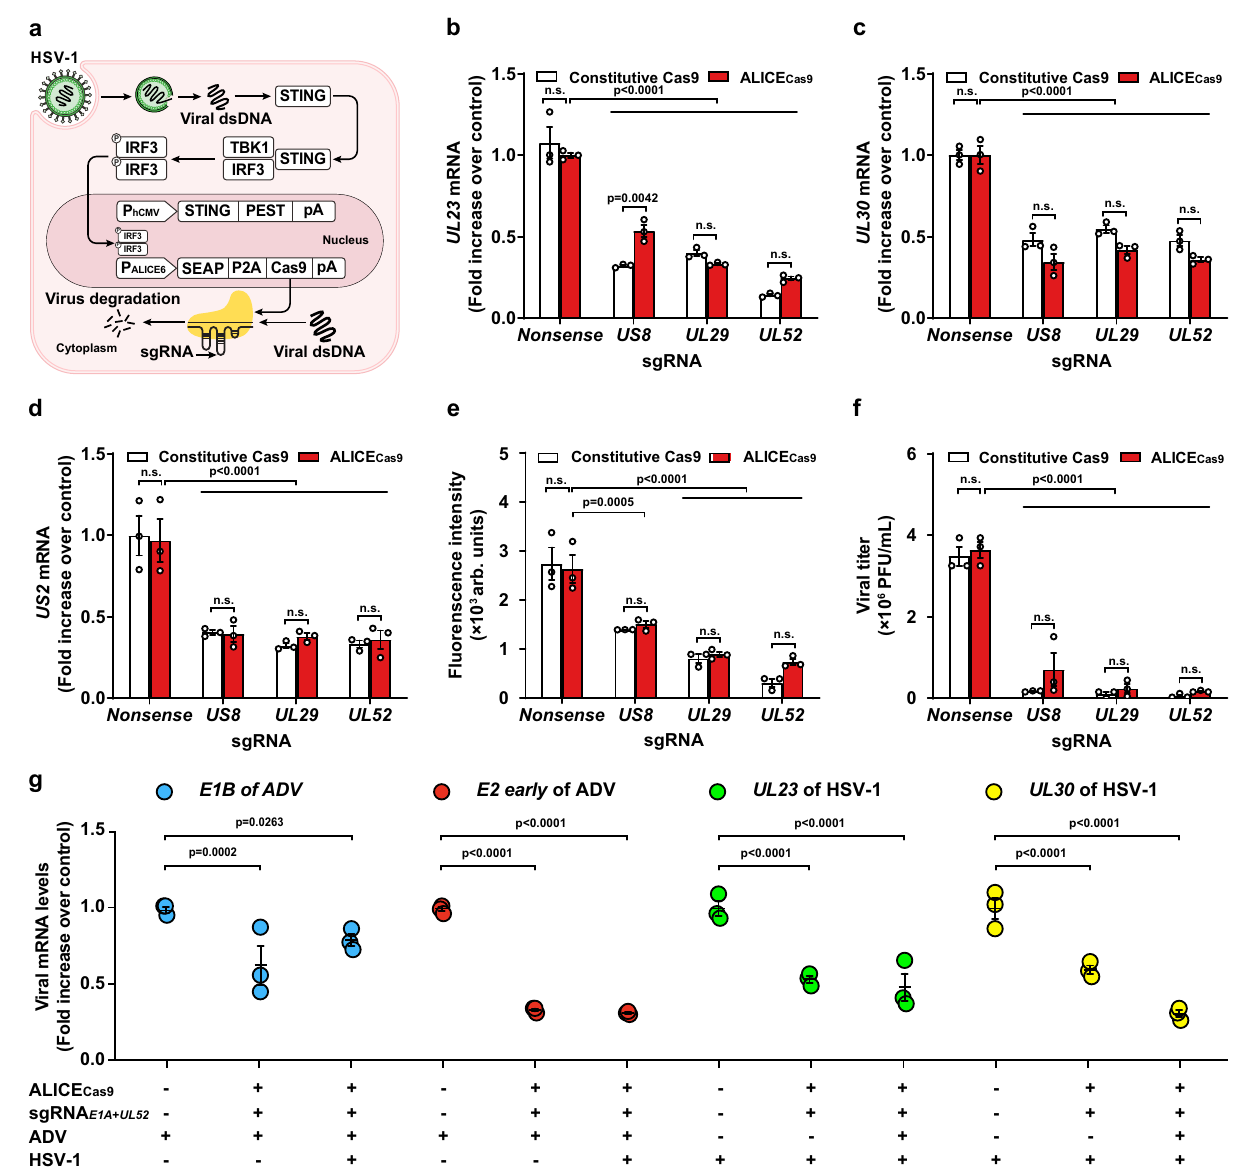
Fig. 2 | Design and validation of an autonomous, intelligent, antiviral, virus- inducible immune-like sense-and-deletion cells (ALICE Cas9 cells). a Schematic illustration of the design principle of ALICE Cas9 cells for autonomous sense-and- deletion of HSV-1. HSV-1 activates the virus sensor and initiates the expression of theCas9proteinunderthecontrolofthevirus-induciblepromotor(P ALICE6 ).HSV-1- inducible Cas9 protein inhibits viral replication by targeting and deleting highly conserved virusreplication-related genes US8/UL29/UL52 underthe guidanceofits corresponding sgRNA. b qPCR analysis of mRNA levels of the viral transcript UL23 fromEGFP-labeledHSV-1.TransfectionofHSV-1-targetingsgRNA[highlyconserved virus replication related gene: US8 locus (pYW102); UL29 locus (pYW172); UL52 locus (pYW188), and a nonsense control locus (pWS68)] with pYW274/pYW169 or constitutive Cas9 (pYW54) was performed 20h prior to EGFP-labeled HSV-1 infec- tion (MOI=5) in HEK-293T cells. The relative mRNA expression of UL23, UL30 ( c ), and US2 ( d ) was quanti fi ed by qPCR. All data were respectively normalized to the